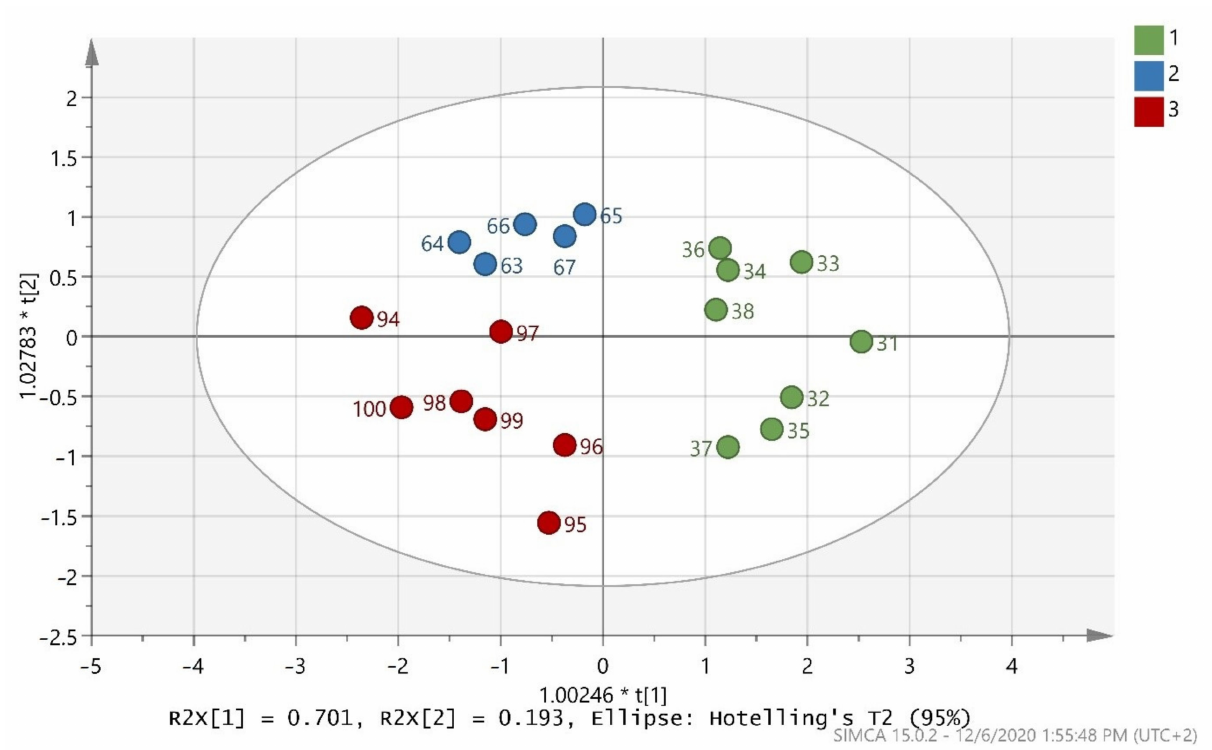
Figure 1. Score scatter plot (t2/t1) from OPLS-DA modeling of the training set where 1 = Maurolia (Messinia), 2 = Lianolia Kerkyras (Preveza), and 3 = Koroneiki (Preveza). A = 2 + 1 components, R 2 X(cum) = 0.998, R 2 Y(cum) = 0.723, and Q 2 (cum) = 0.708 and 1.0014 * t[1] means 1.0014 × t[1].